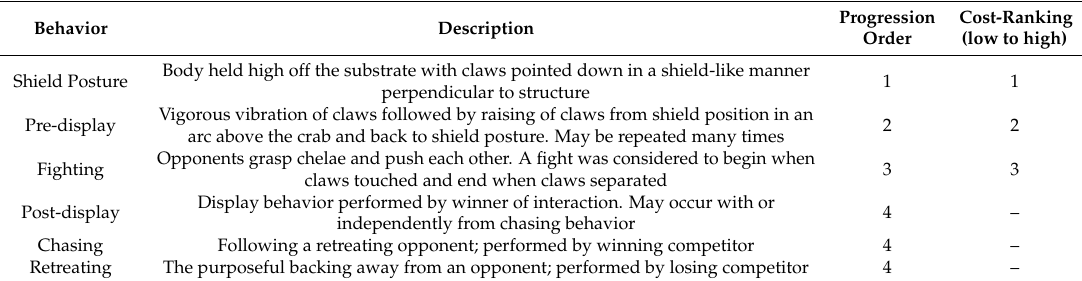
Table 2. Ethogram of behaviors in the A. pisonii ritualized aggression progression. Adapted from [16]. Behavior Description